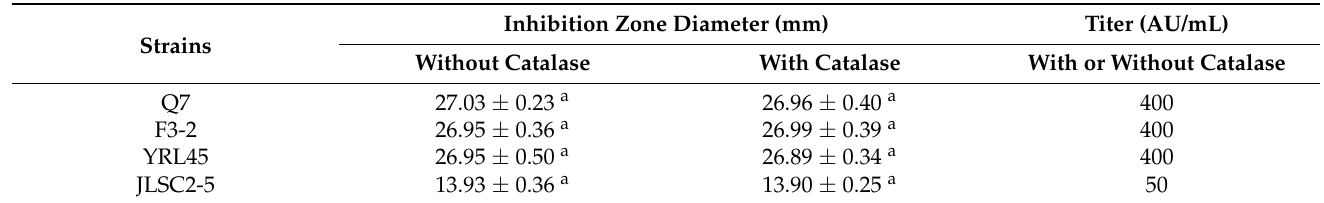
Table 3. Effect of catalase on antibacterial activity of L. plantarum Q7, L. plantarum F3-2, L. plantarum YRL45 and L. plantarum JLSC2-5.